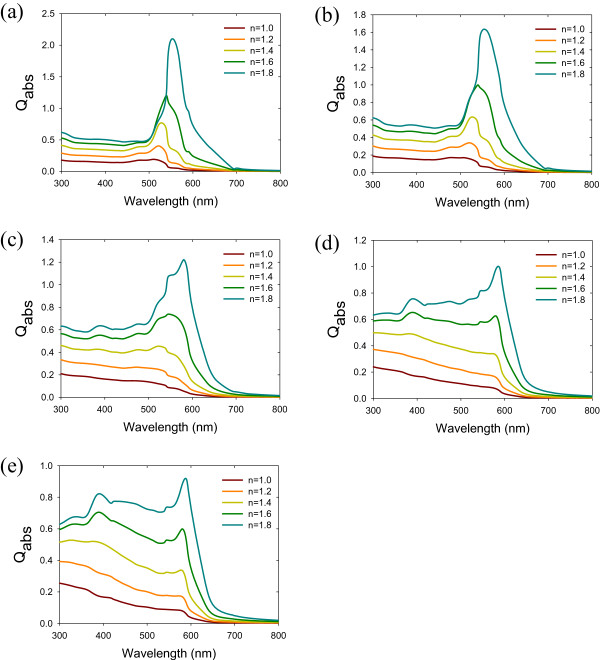
Extinction of different refractive index. (a) Au, (b) Au3Cu, (c) AuCu, (d) AuCu3, and (e) Cu alloy nanoparticles.